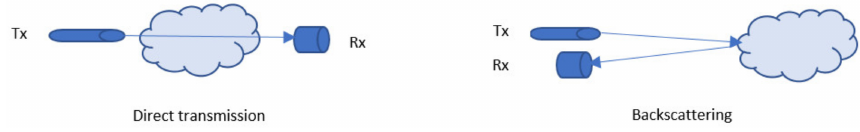
Figure 5. Optical power measurement